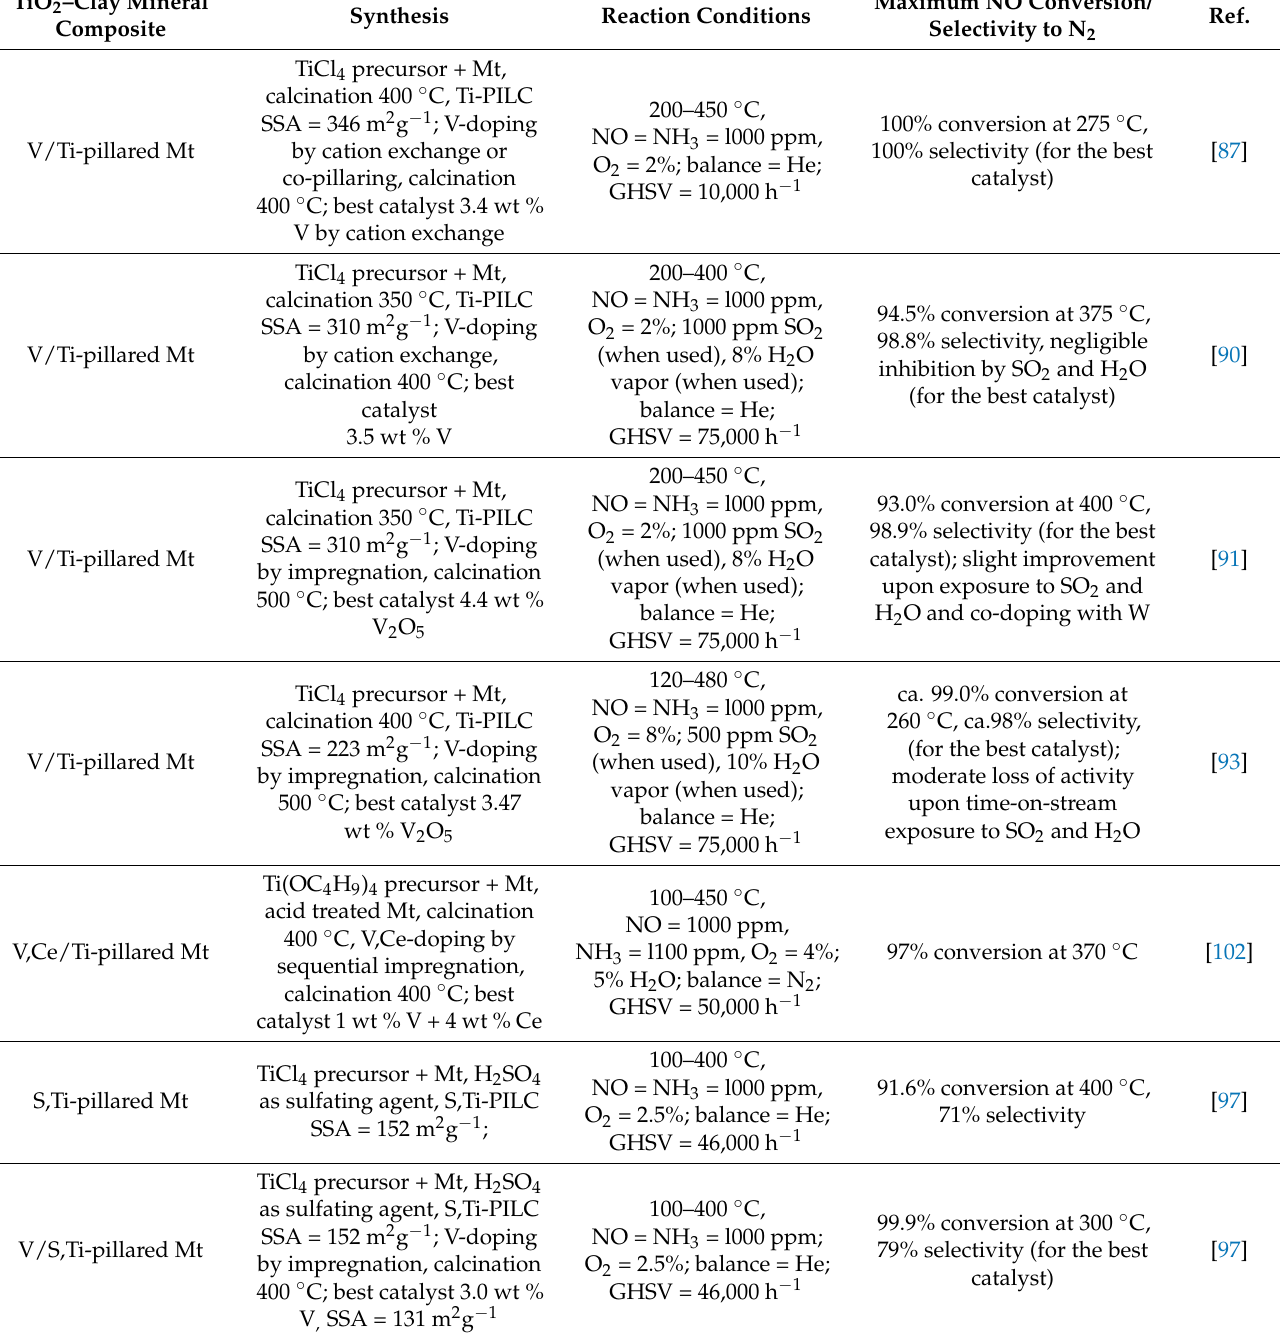
Summary of the main synthesis and catalysis data for the most relevant examples of TiO 2 –clay min- eral composites used as catalysts for the NH 3 SCR of NO x (Mt—montmorillonite, Pal—palygorskite,